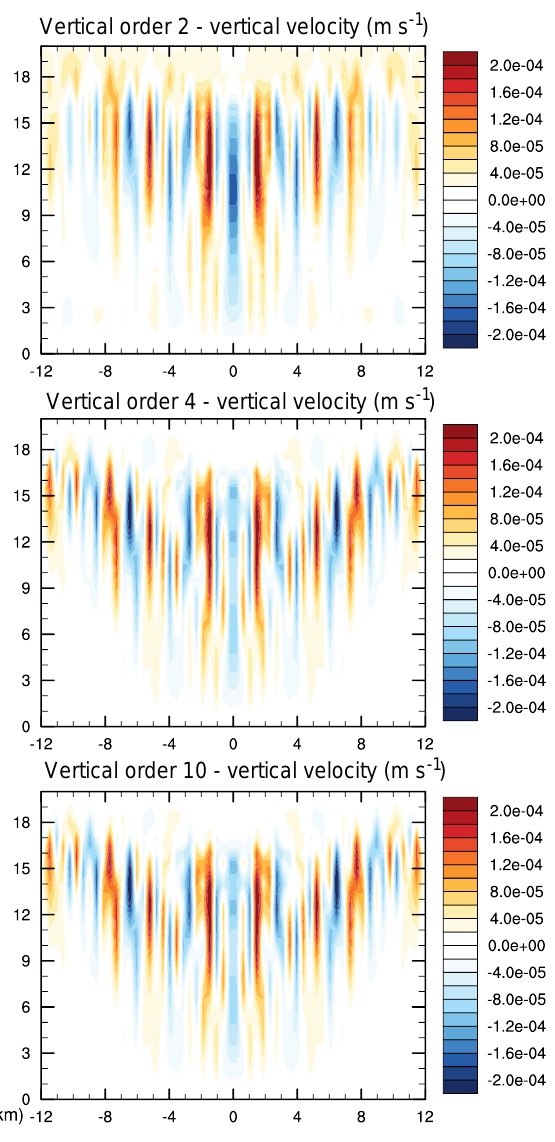
Figure 8. Still atmosphere experiment over Schär mountain profile at vertical orders 2, 4, and 10 showing errors in vertical velocity. (cid:49)x = 500m and (cid:49)z = 500m. Contour interval: 2 . 0 × 10 − 5 ms − 1